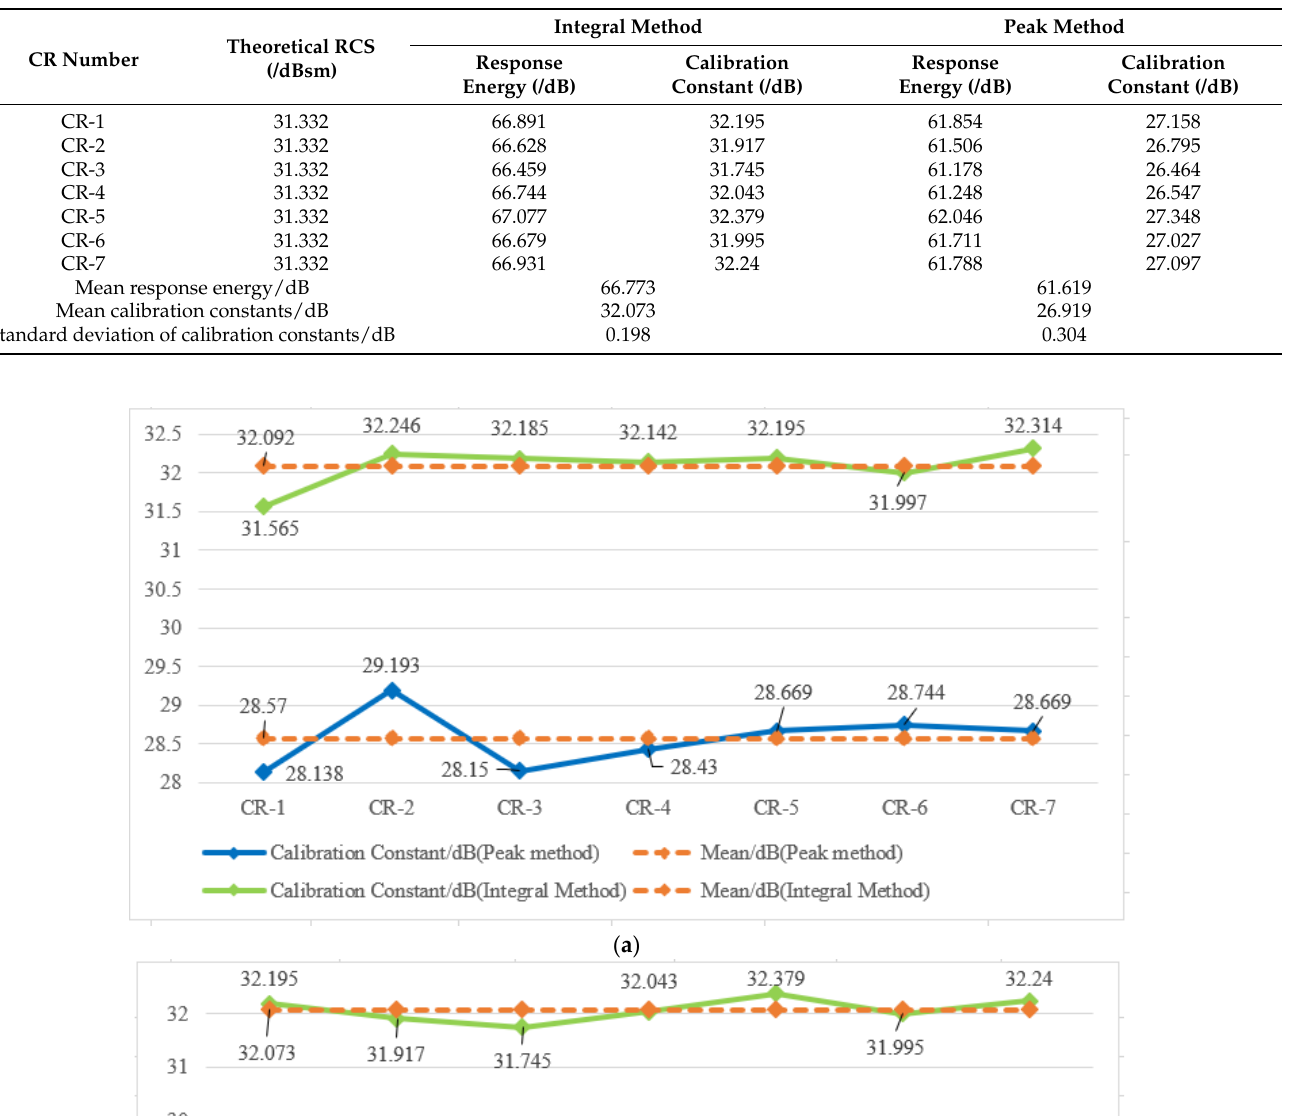
Table 7. Response energy and calibration constant results of each point target for FSI mode data on 15 May.